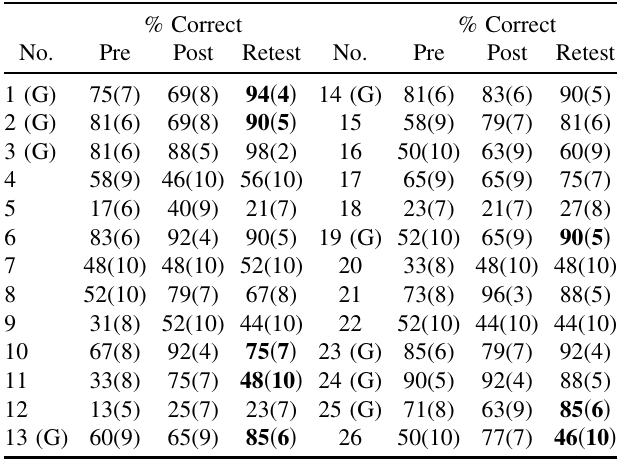
TABLE XI. Detailed MBT results. Questions included in subtest G are denoted by a (G) following the number. Uncertainties are given in parentheses. Bold numbers denote a significant posttest to retest